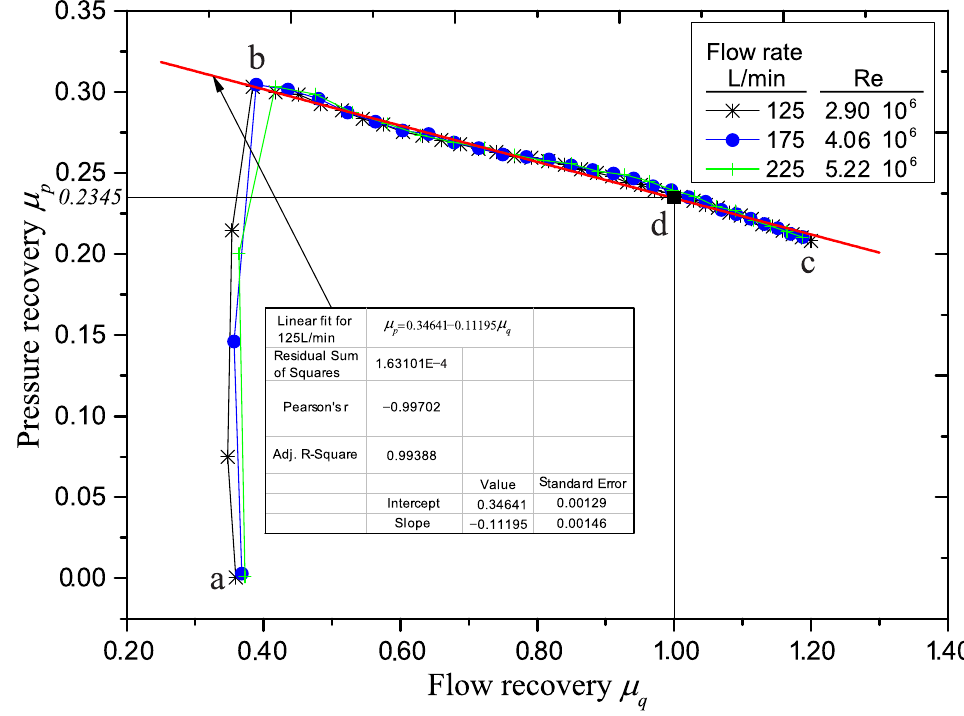
Figure 6. The pressure recovery vs flow recovery dependences obtained at different Reynolds numbersin the forward movement of the impact body.